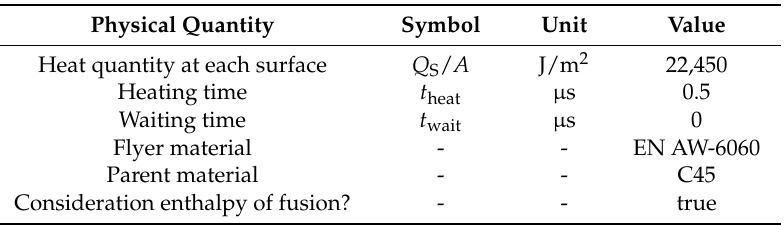
Table 5. Parameters of the reference setup.